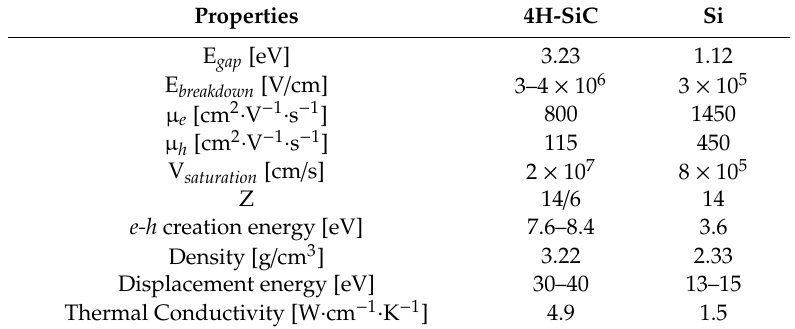
Table 1. Main properties of the silicon carbide material, employed for the telescope ∆ E